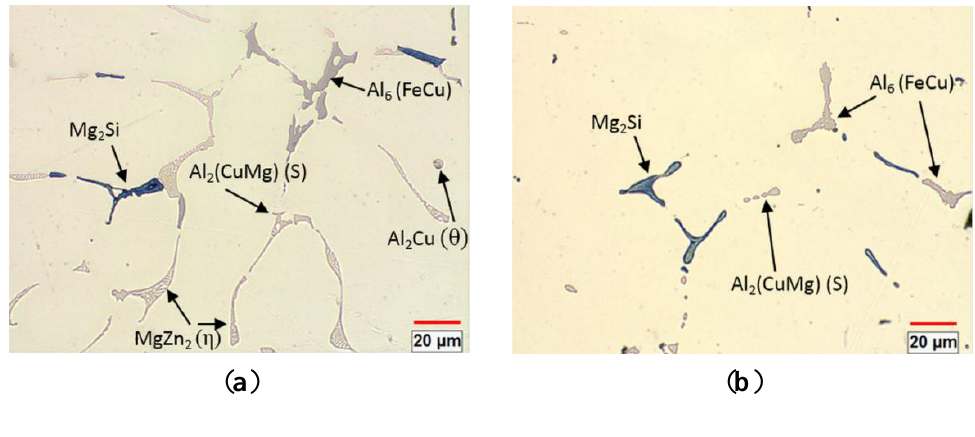
Figure 1. The optical micrographs of the alloy: ( a ) as-cast microstructure; and ( b ) as-homogenized